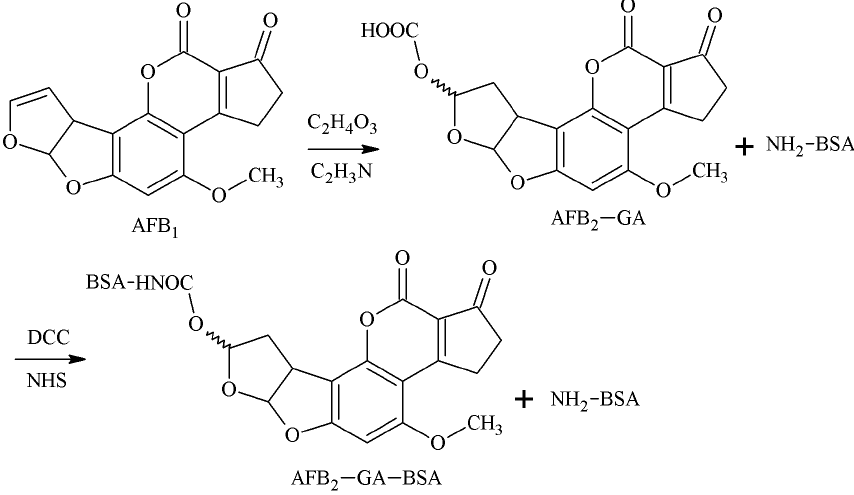
Figure 7. Synthesis of the AFB1-BSA antigen by the enol ether derivative (EED) method.